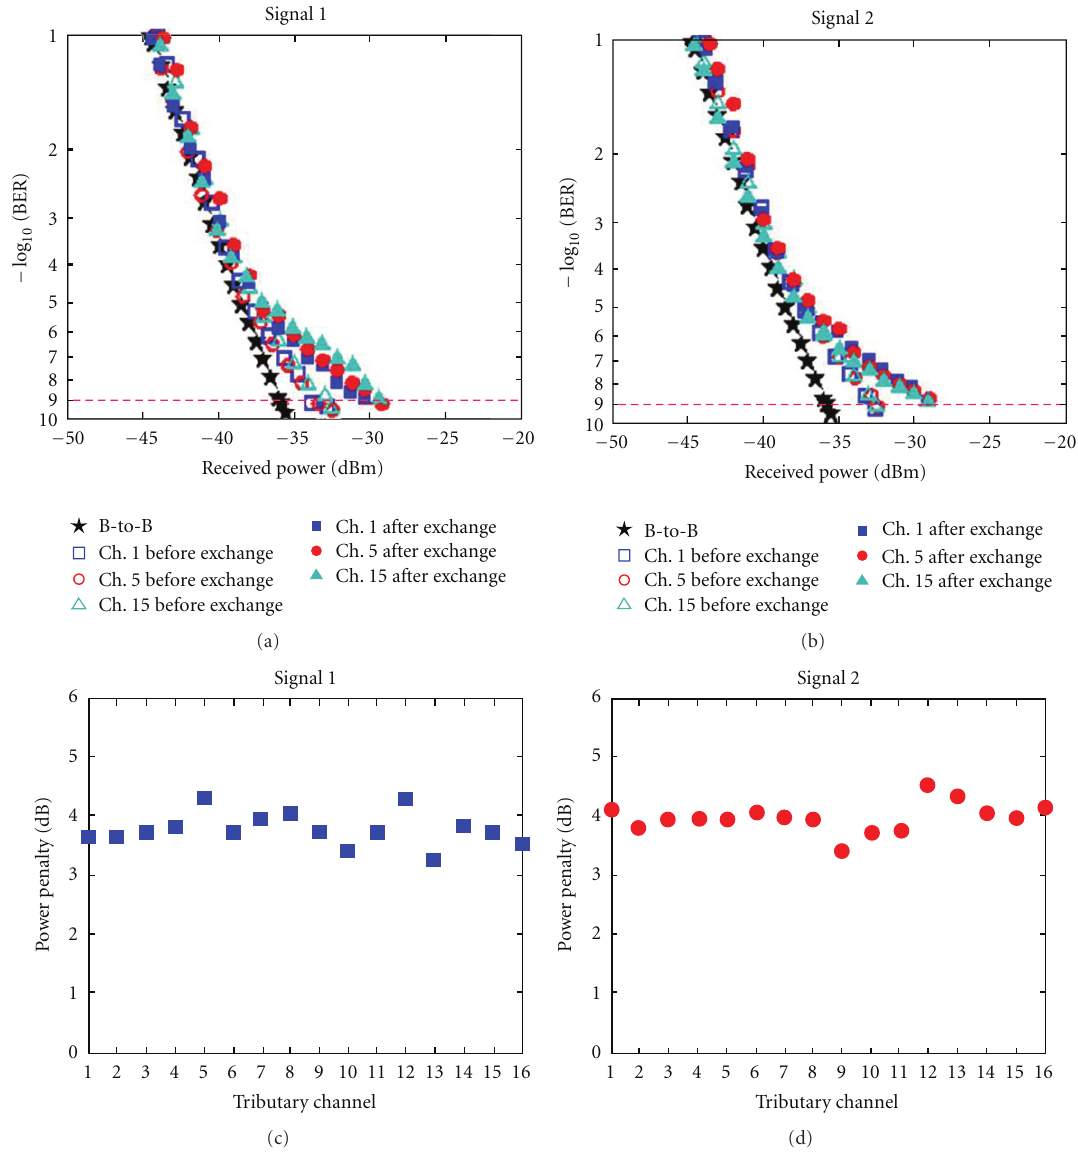
Figure 10: (a and b) BER performance for the tributary channel exchange. (c and d) Power penalties of tributary exchange for 16 tributary channels. (a and c) Signal 1. (b and d) Signal 2.